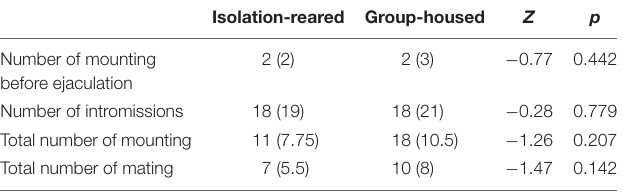
TABLE 4 | Results of heterosexual behavior